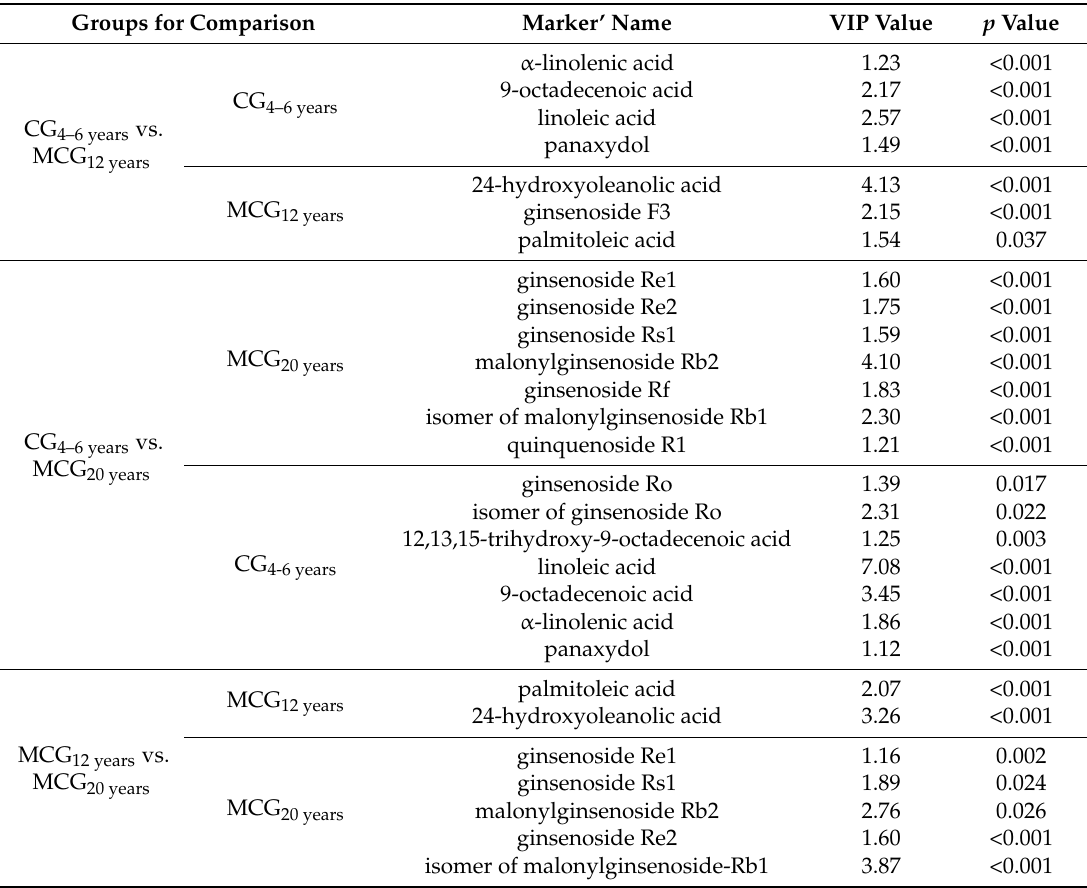
Table 3. The summary table with variable identity, VIP and p